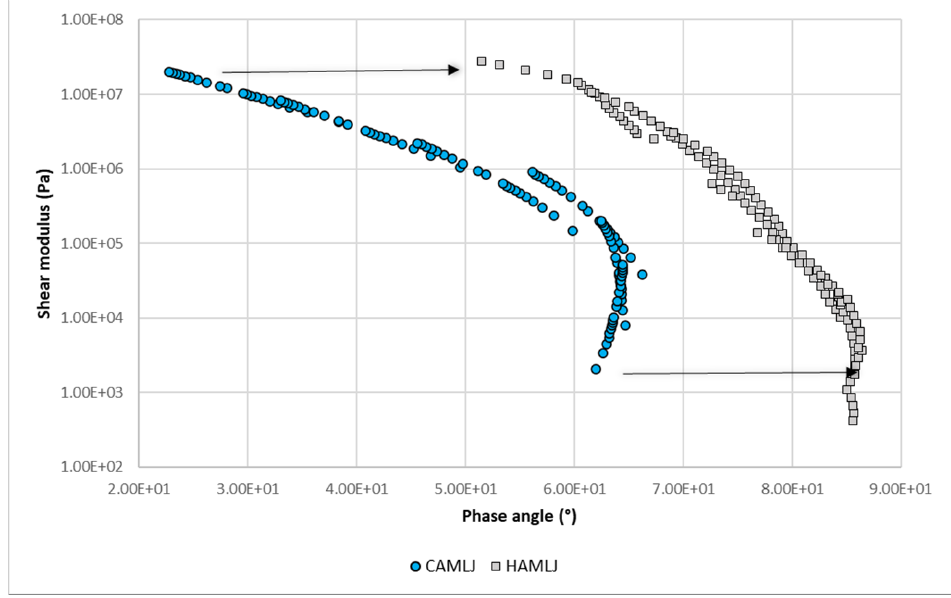
Figure 11. Black diagram of CAMLJ vs. HAMLJ.